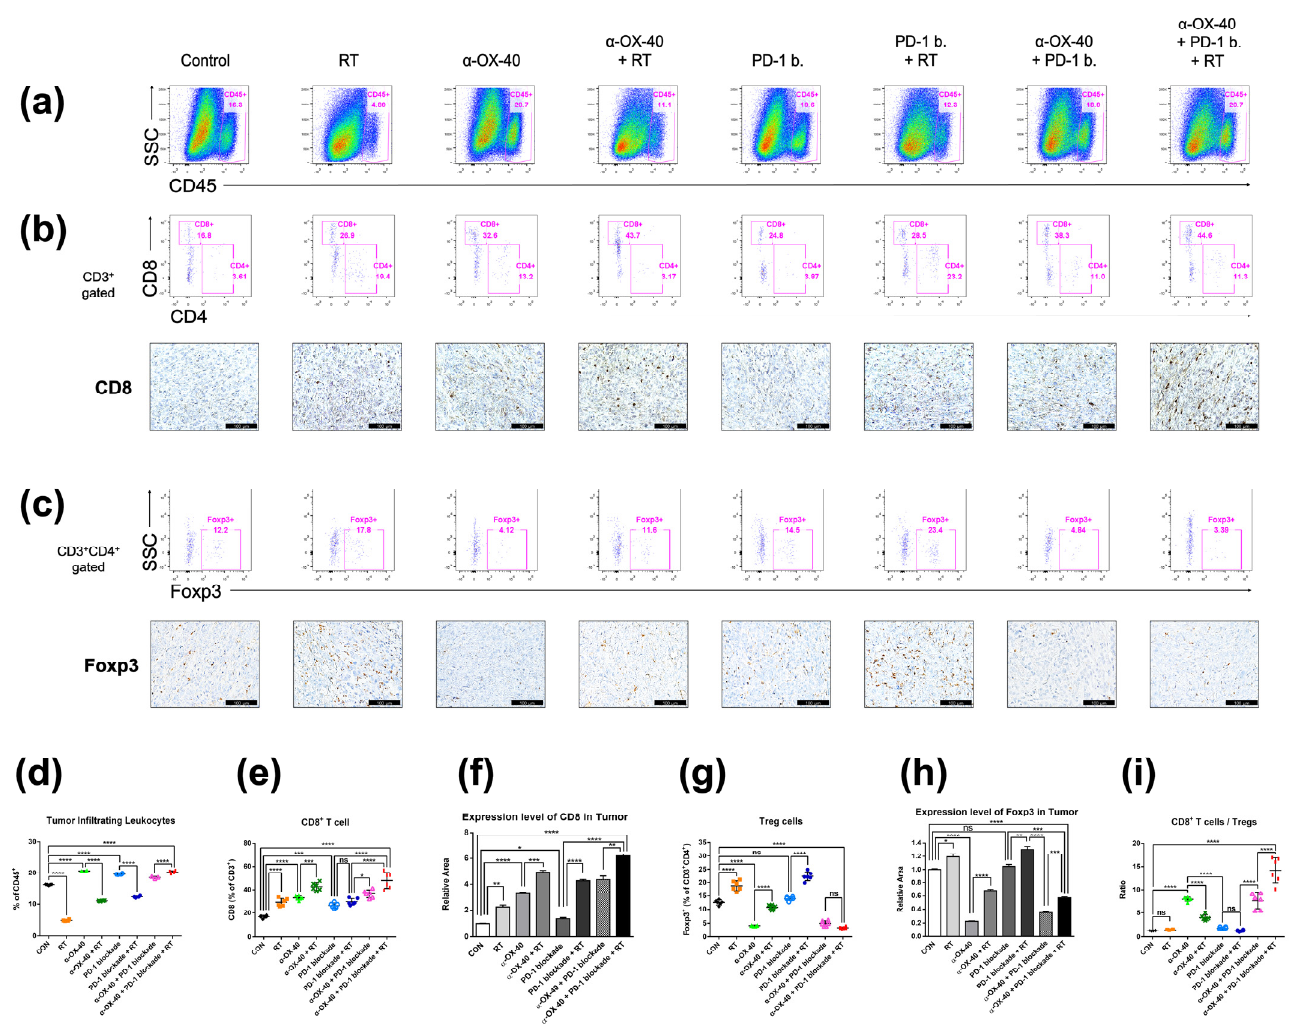
Figure 3. Immune cell profiles in the tumor microenvironment. Representative flow cytometry plots and immunohistochemistry images of ( a ) CD45+ tumor-infiltrating leukocytes, ( b ) CD4+ or CD8+ T cells, and ( c ) CD4 + FOXP3+ Tregs. ( d – i ) Cell population percentages calculated from flow cytometry analyses and immunohistochemistry. * p < 0.05, ** p < 0.01, *** p < 0.001, **** p < 0.0001. Abbreviations: CON, control; RT, radiotherapy; Treg, regulatory T cell; ns, not significant.